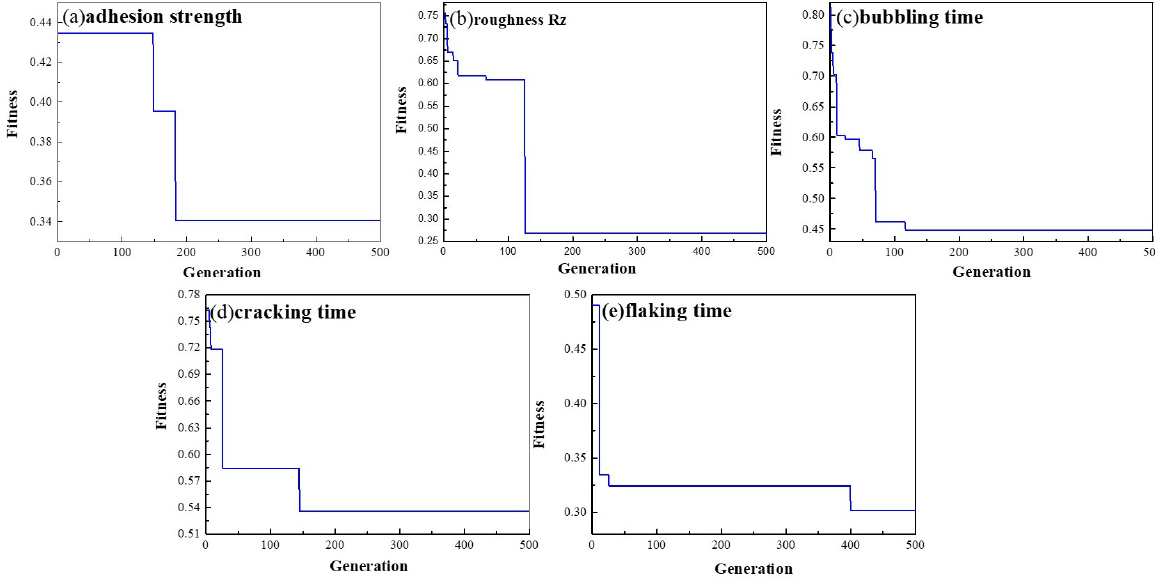
Figure 12. Fitness evolution curve: ( a ) adhesion strength; ( b ) roughness Rz; ( c ) bubbling time; ( d ) cracking time; ( e ) flaking time.